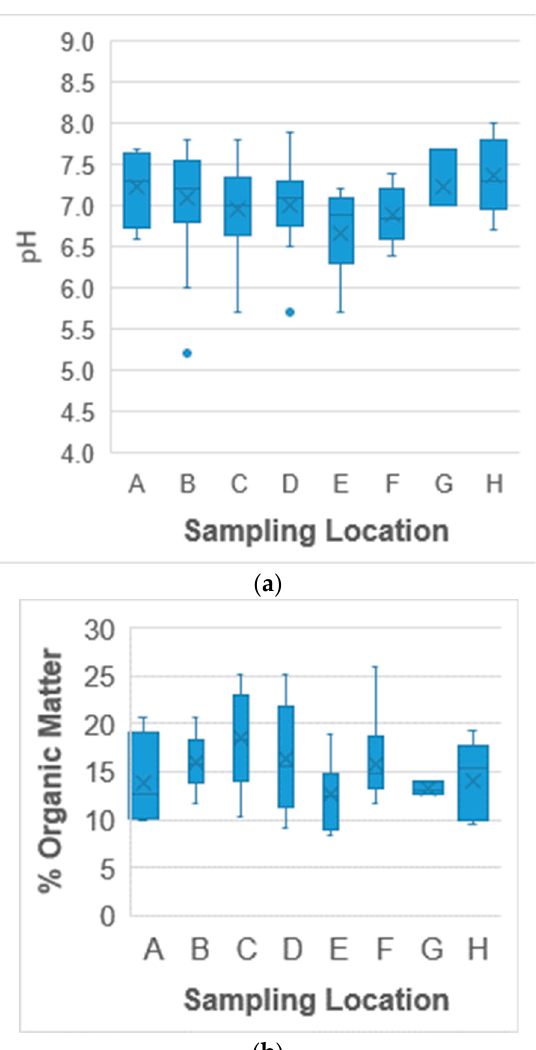
Figure 2. Characteristics of the soils from Walker Riverside Park. ( a ) Acidity and ( b ) organic matter content. The x refers to the mean value, the shaded boxes represent the 95% confidence limit of the data while the whiskers represent variability outside the upper and lower quartiles and beyond the whiskers are outlier data points, per sampling location (A–H), see Figure 1a.